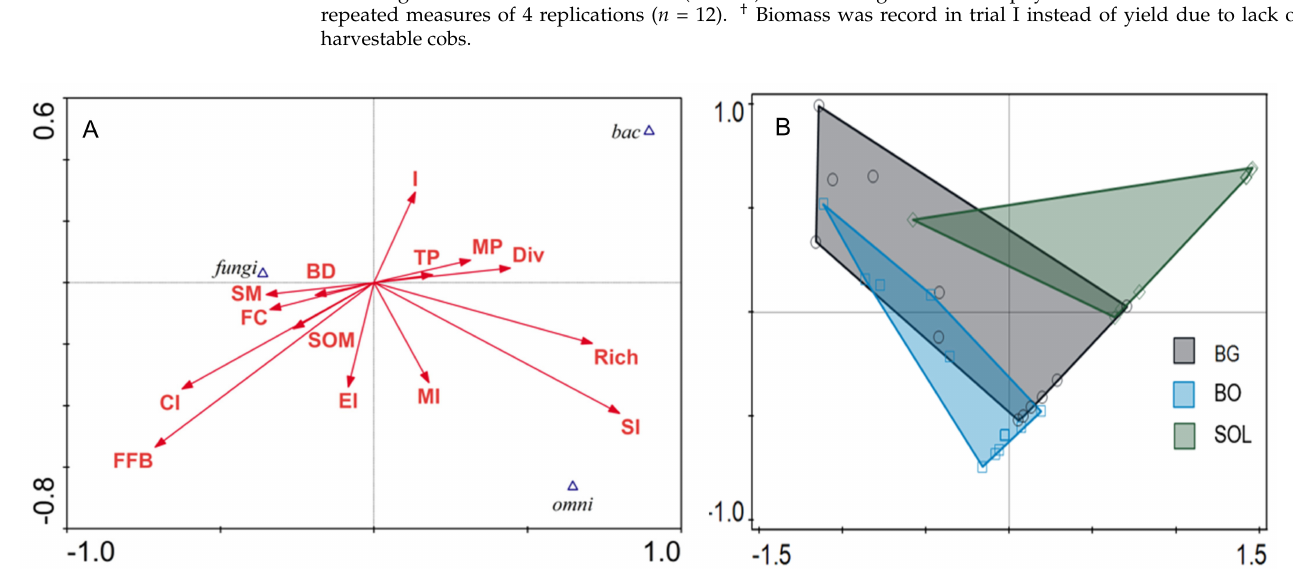
Figure 3. ( A ) Ordinance diagram of trial I depicts the first two canonical axes of a canonical correspon- dence analysis between the free-living nematode abundance (bac = bacterivores; fungi = fungivores; omni = omnivores) and environmental variables (BD = bulk density; Div = diversity; FC = field capacity; FFB = fungi/fungi + bacteria; I = infiltration rate; TP = total soil porosity; MP = macrop- orosity; SOM = soil organic matter; SM = soil moisture; CI = channel index; EI = enrichment index; SI = structure index; MI = maturity index; Rich = Richness). The first two axes explained 100% of the variance. ( B ) Scatter plot of samples on the first two principal component axes explaining 82.91% of the variance from no-till black oat (BO), bare ground (BG), and solarization (SOL)